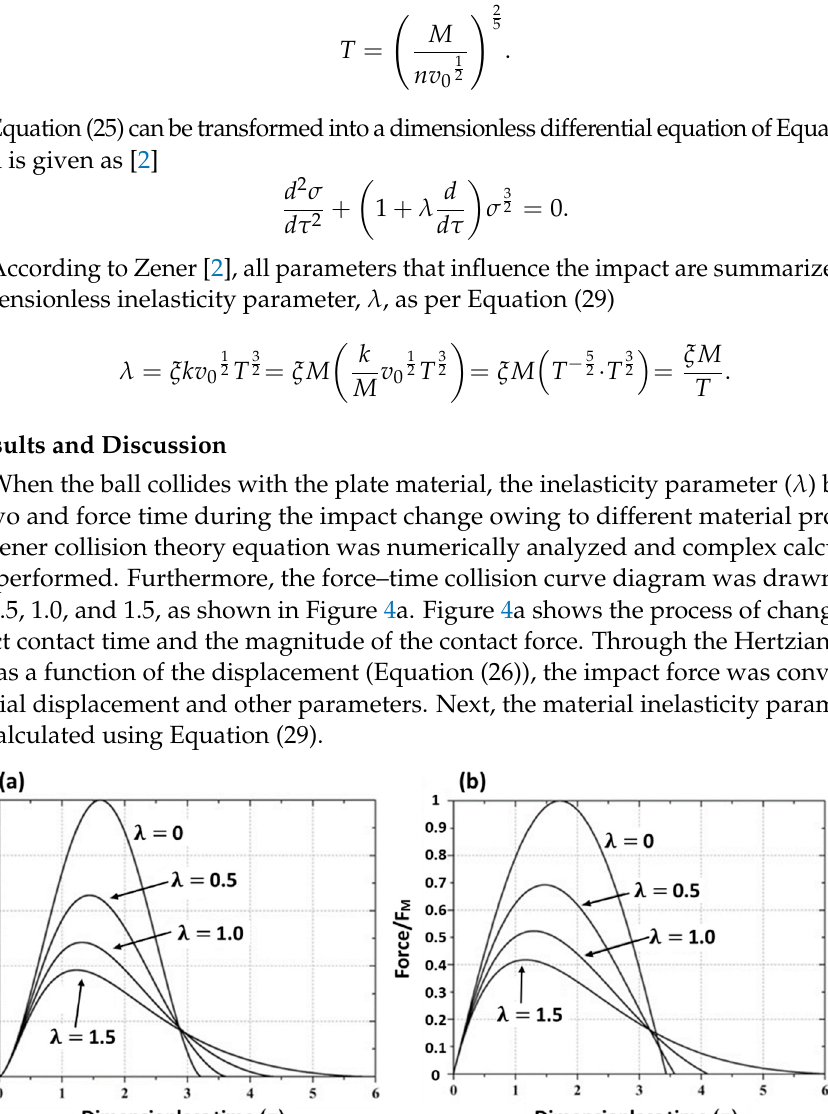
Figure 3. Ball collides with a plate via ( a ) elastic and ( b ) inelastic collisions.